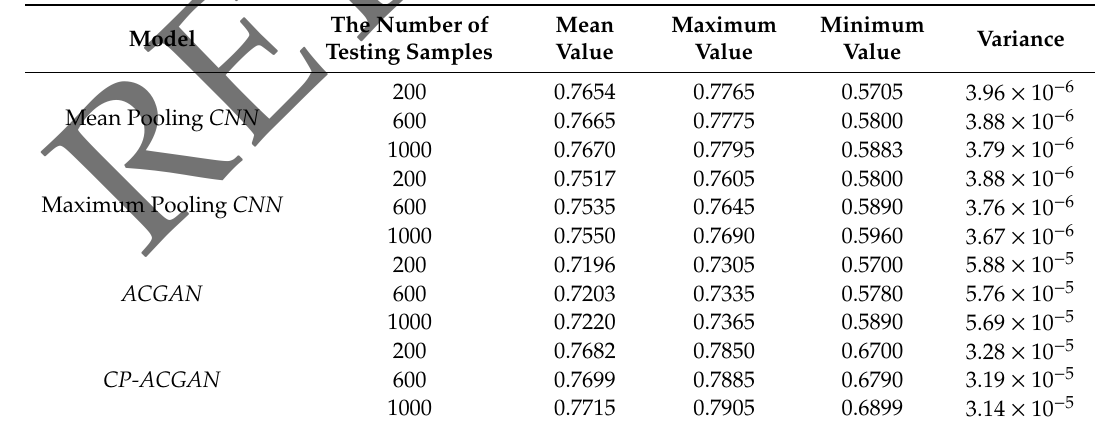
Table 3. CIFAR10 prediction accuracy. Mean value, maximum value, minimum value and variance of different methods in 1000 tests.